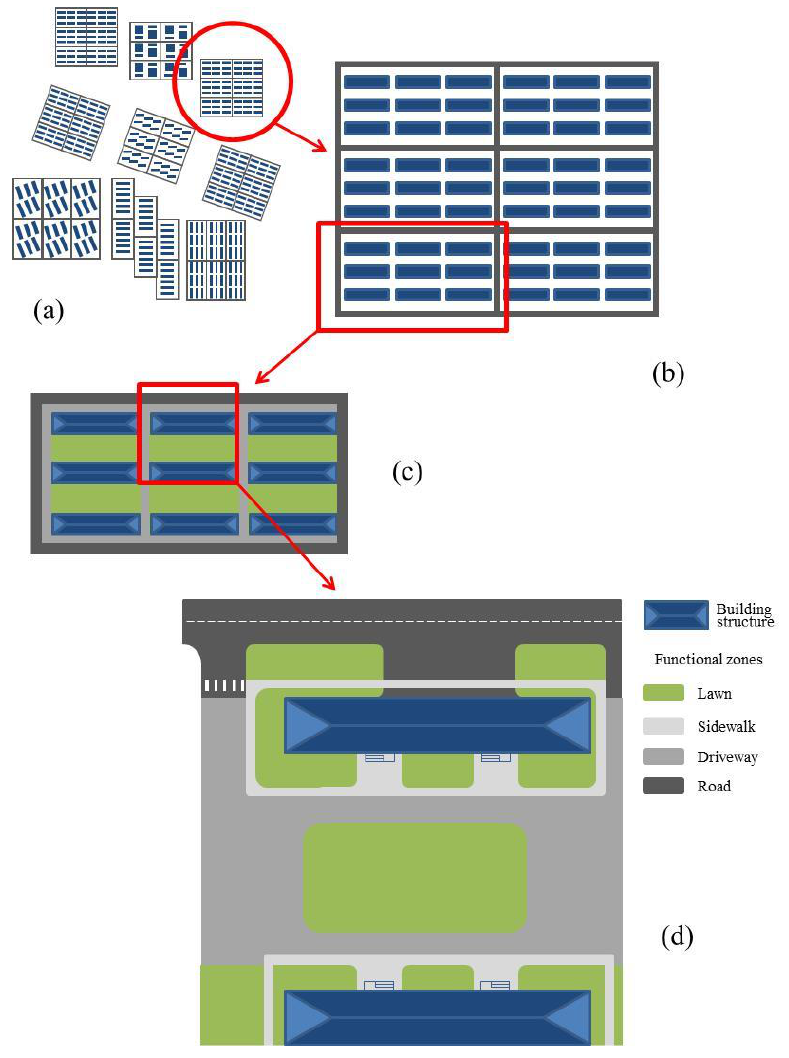
Figure 2. Typical structure of a residential area in a Russian city. ( a ) City’s residential area; ( b ) Microrayon; ( c ) Block of buildings; ( d ) EURL.